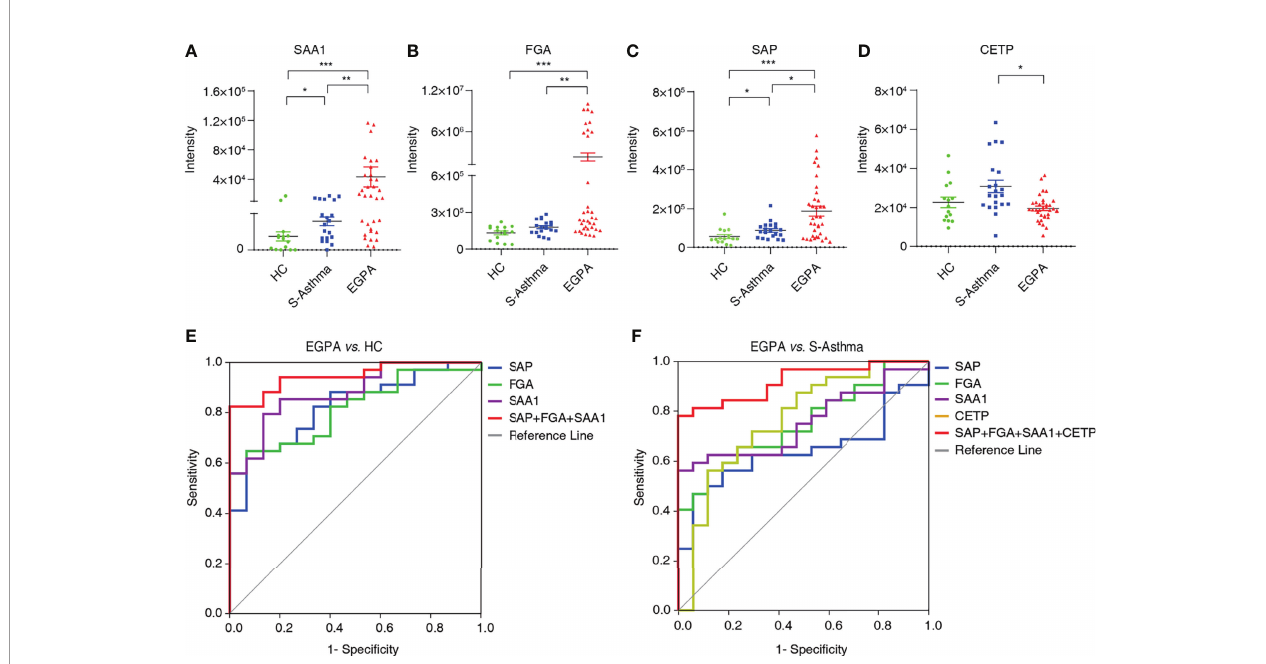
FIGURE 4 | Validation and evaluation of candidate biomarkers. The quanti fi cation of serum SAA1 (A) , FGA (B) , SAP (C) , and CETP (D) in healthy control, severe asthma, and EGPA groups (* p < 0.05; ** p < 0.01; *** p < 0.001). (E) Receiver operating characteristic curve analysis of candidate biomarkers for EGPA vs. HC. (F) Receiver operating characteristic curve analysis of candidate biomarkers for EGPA vs. S-asthma. EGPA, eosinophilic granulomatosis with polyangiitis; HC, healthy controls.